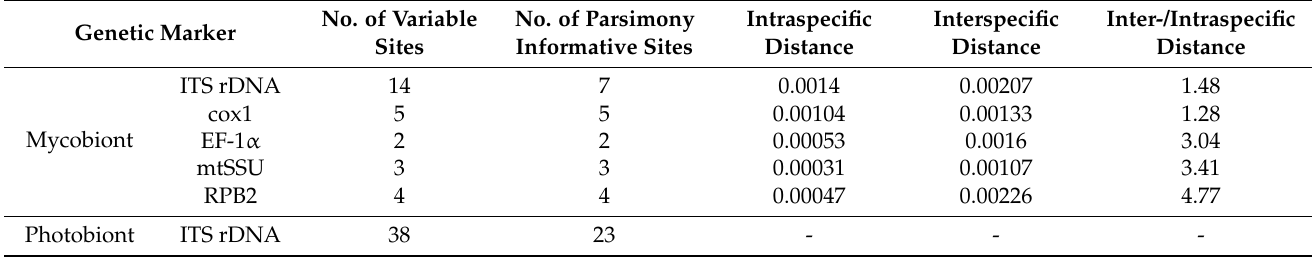
Table 2. Comparison of the resolution of molecular markers used in this study.